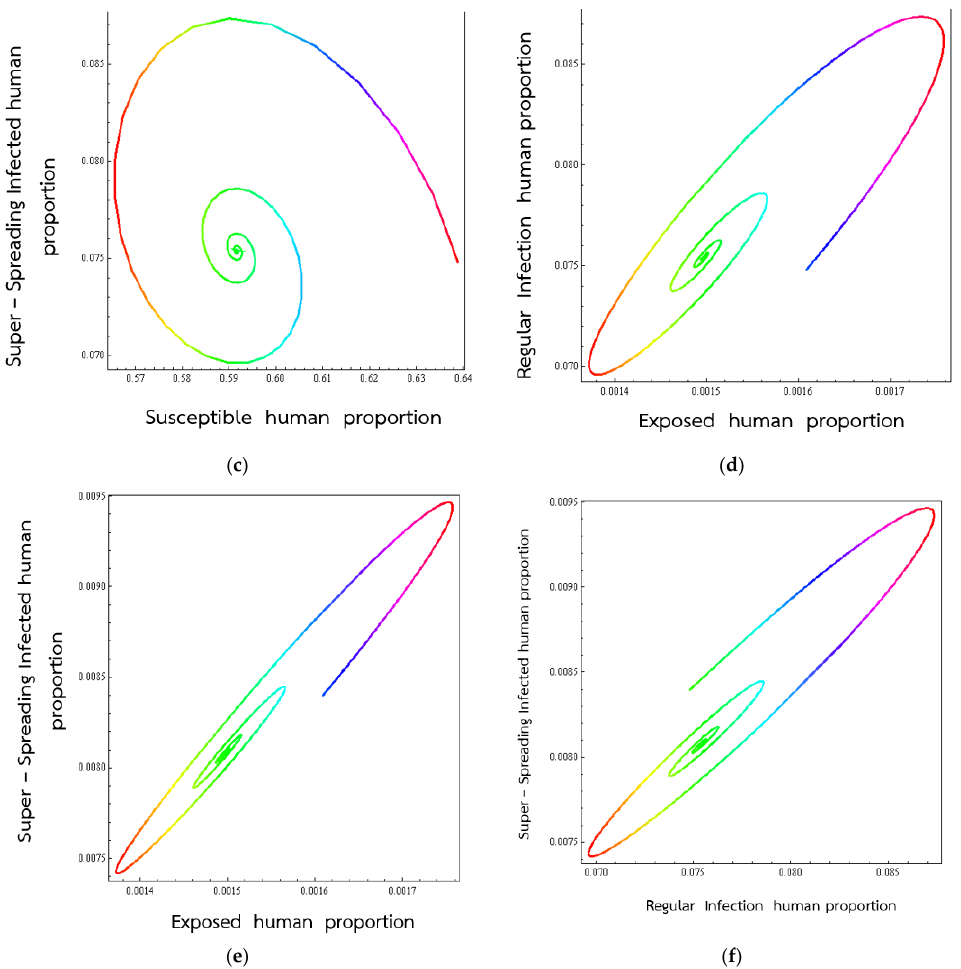
Figure 4. Trajectories of respiratory disease for the solutions equation approach to the endemic state dependence of onto (S, E) ( a ), (S, I r ) ( b ), (S, I S ) ( c ), (E, I r ) ( d ), (E,I s ) ( e ), (I r , I S ) ( f ), respectively.